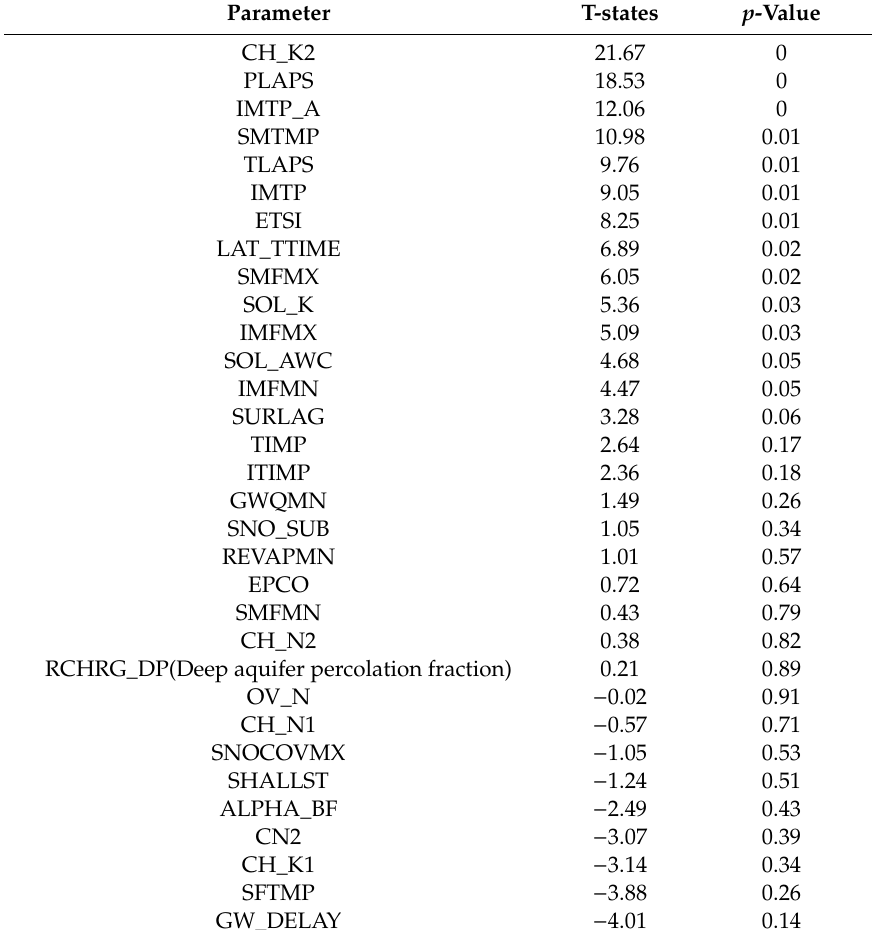
Table 5. Parameter information for global